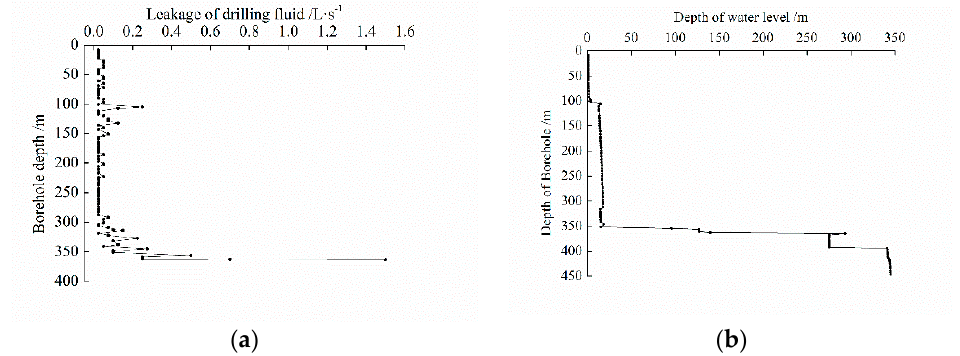
Figure 4. Leakage of drilling fluid and the water level depth measured on site. ( a ) Relationship between leakage of fluid and drilling depth. ( b ) Relationship between water depth and borehole depth.